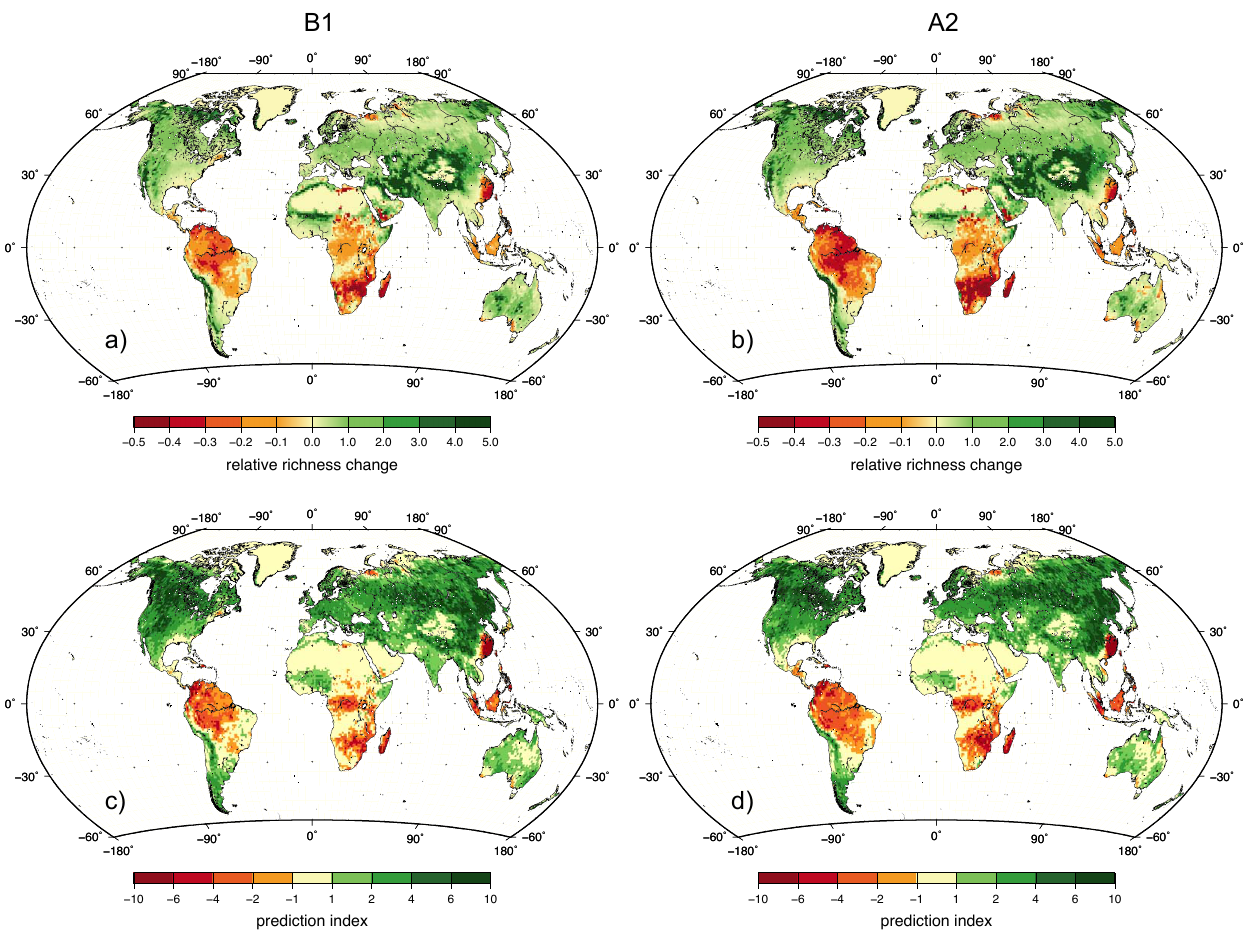
Fig. 2. Mean shifts in the geographic variation of functional richness (FR) between present-day (1960–1989) and future climate scenarios (2070–2099) B1 (a) and A2 (b) . FR increase and decrease is calculated relative to FR of present-day climates. The agreement among the seven JeDi future climate simulations is expressed as prediction index (c, d) . An absolute value greater than 2 indicates a robust result across